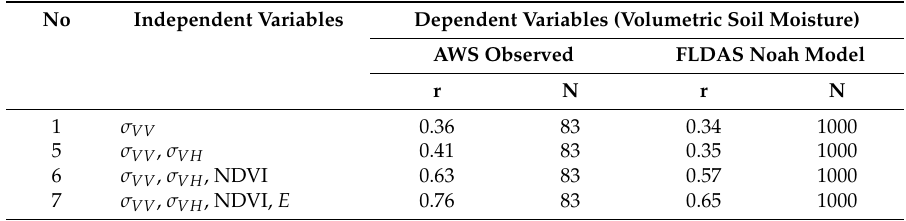
Table 1. Statistical values of simple and linear regression model between independent and dependent